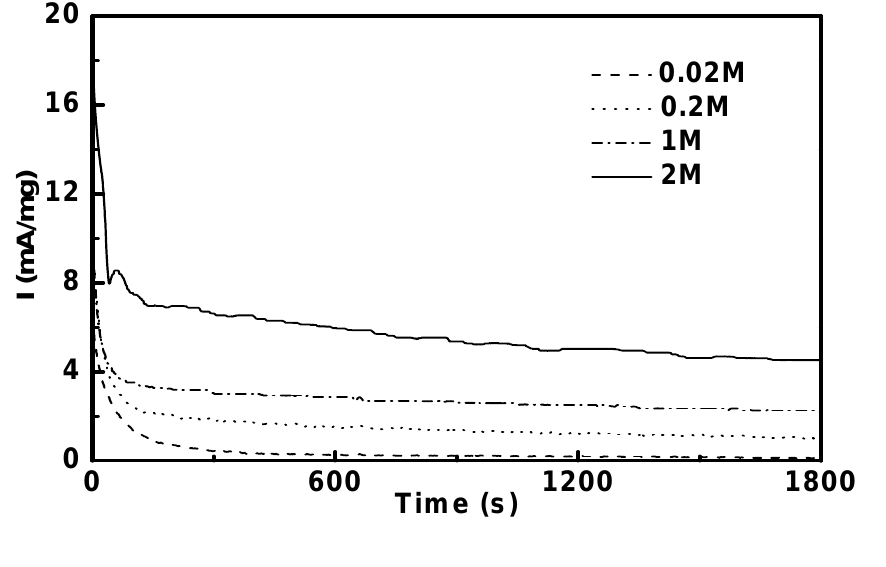
Figure 5. Chronoamperometry collected for methanol electro-oxidation on Pt with different methanol concentrations in 1.0 M H 0.5